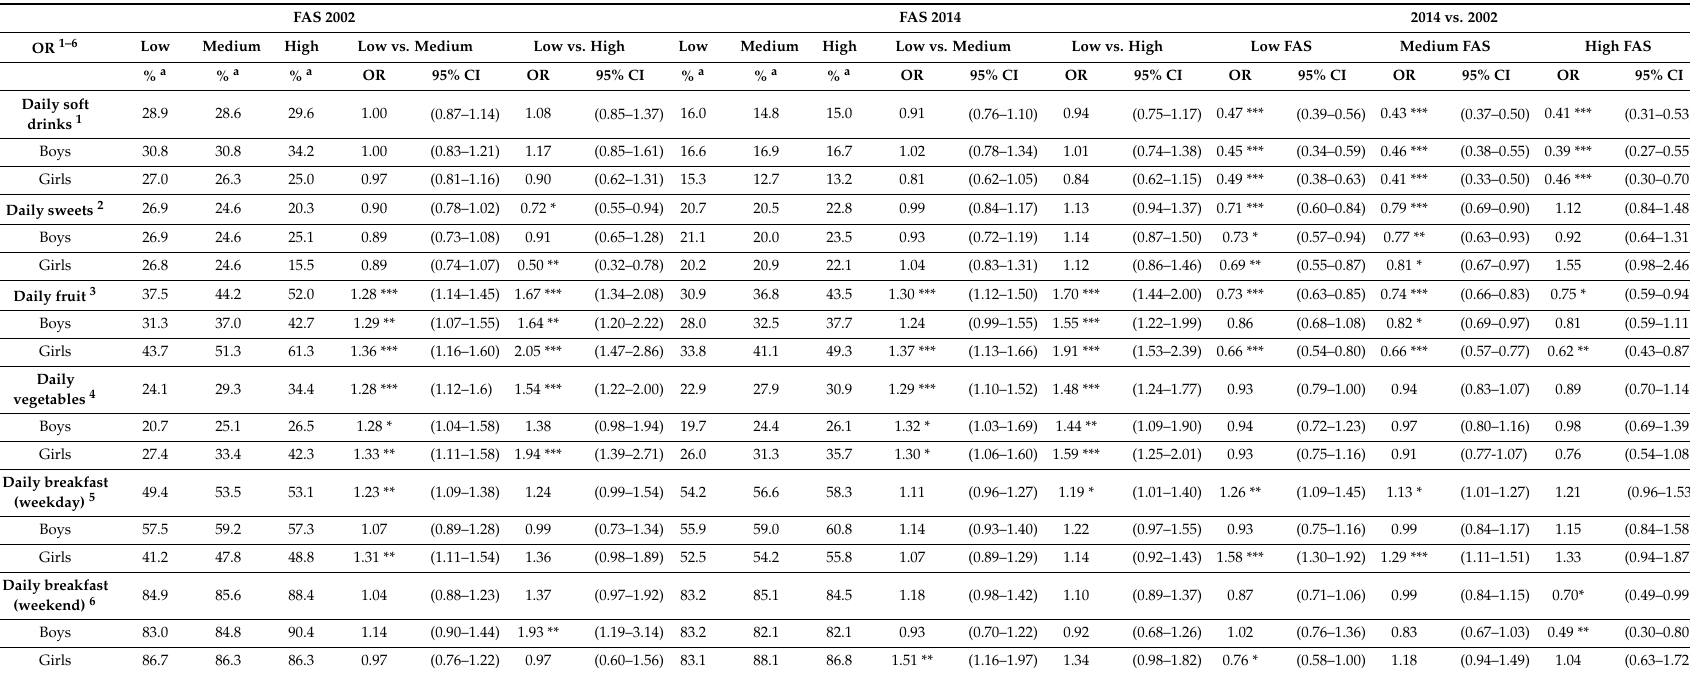
Table 1. Odds ratios of daily consumption by family affluence, 2014 vs.